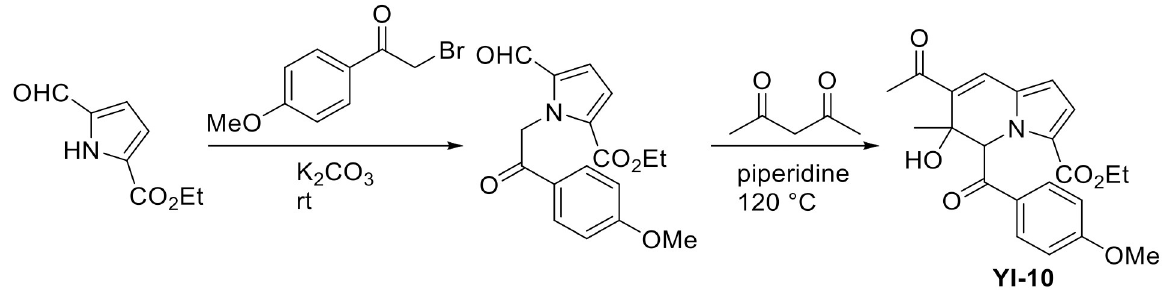
Fig 8. A scheme of synthesizing YI-10.